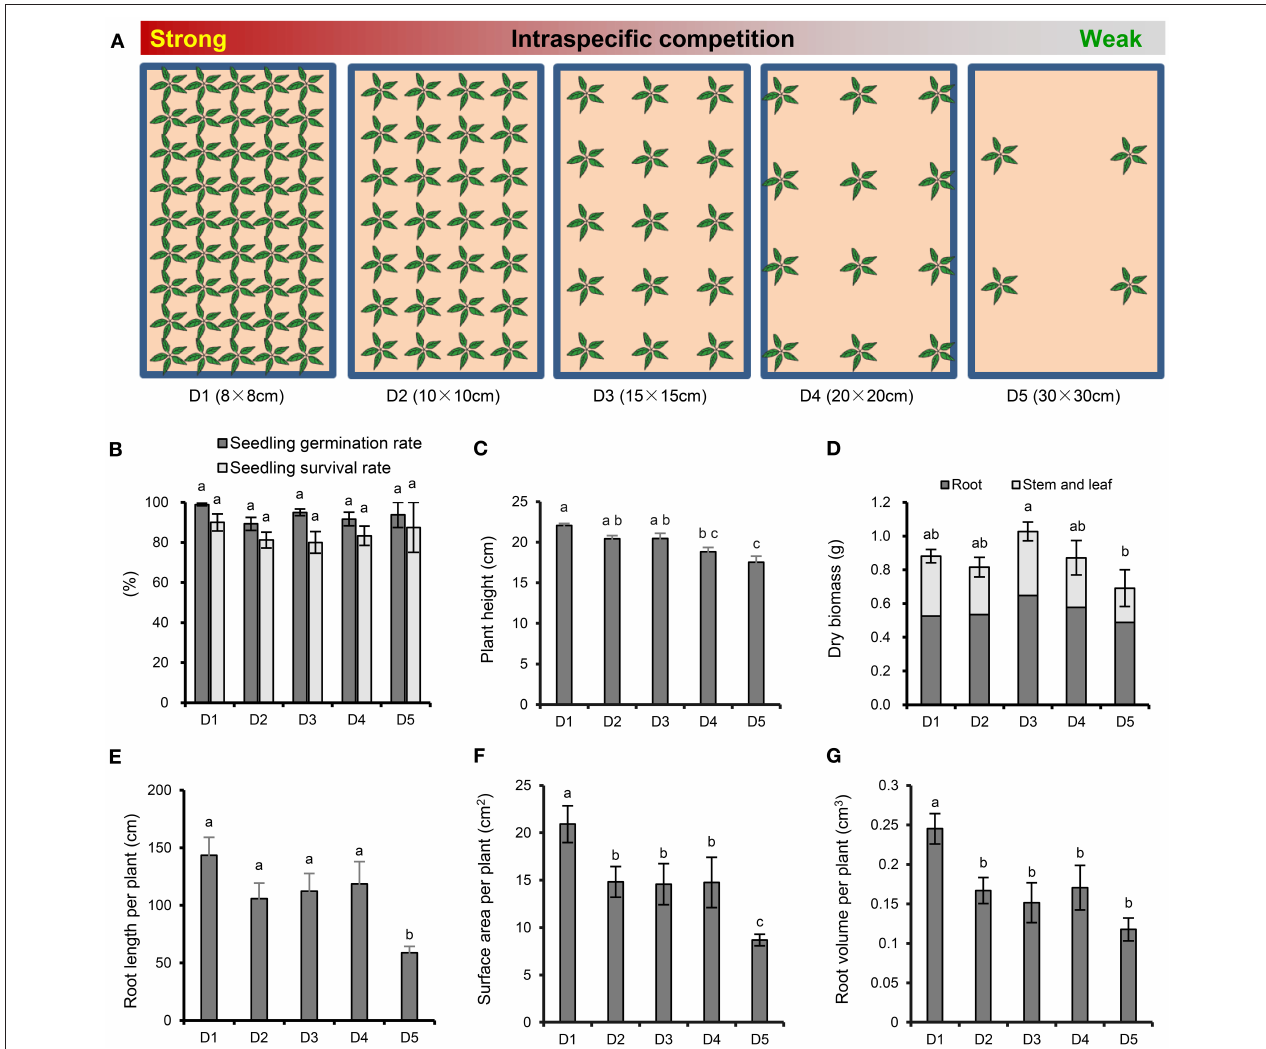
FIGURE 1 | Experimental scheme and effects of plant density on the growth and root morphology of P. notoginseng . (A) Experimental design with five P. notoginseng planting densities. D1 ∼ D5 represent densities of 8 × 8, 10 × 10, 15 × 15, 20 × 20, and 30 × 30cm, respectively. (B) Seedling germination rate and survival rate. (C) Plant height. (D) Dry biomass. (E) Root length per plant. (F) Surface area per plant. (G) Root volume per plant. Error bars indicate the standard error (SE). Different letters indicate statistically significant differences among different treatments ( p < 0.05; n =